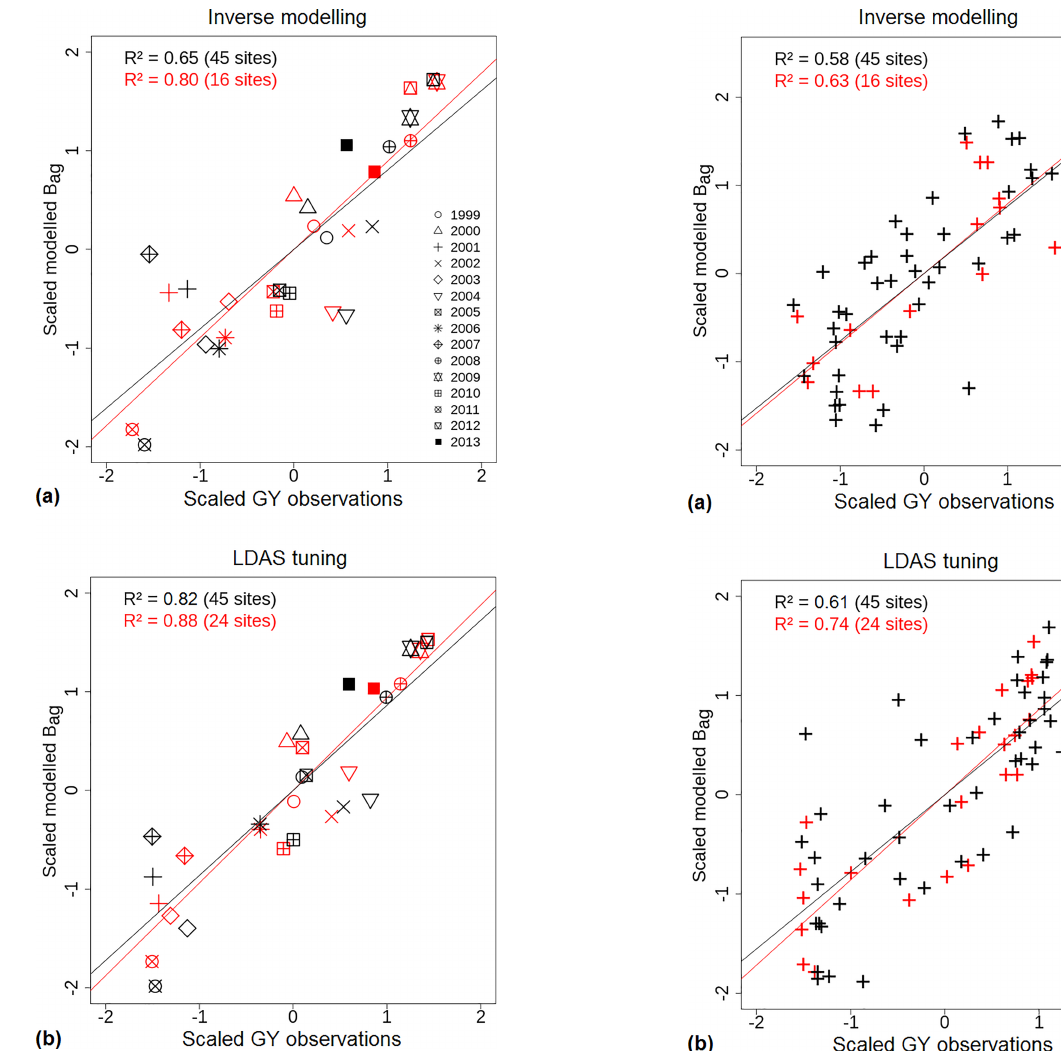
and A s for (red Figure 9. As in Fig. 8, except for spatial B ag X GY